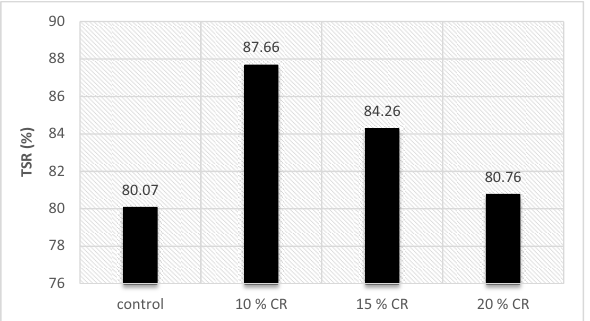
Figure 10: Wet/dry ITS